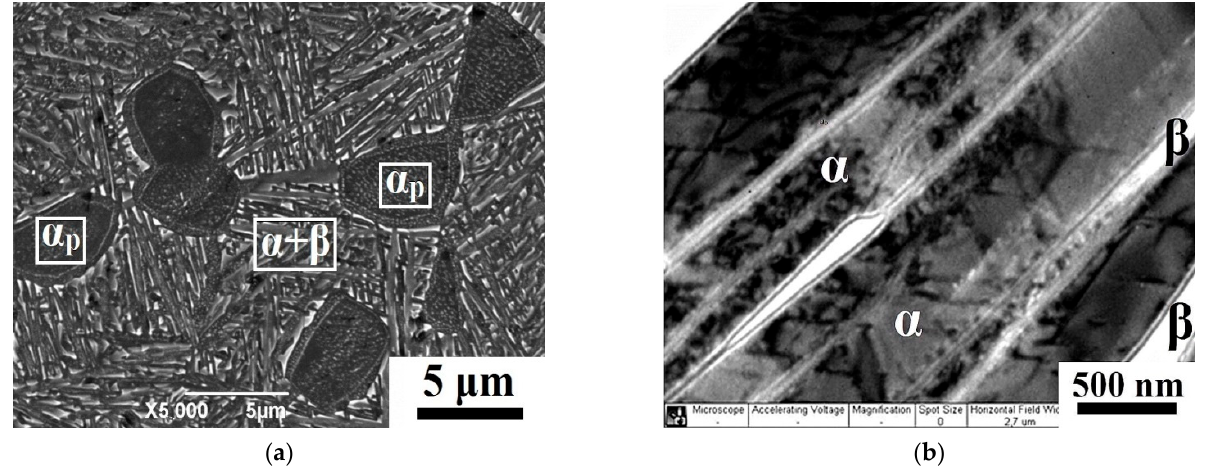
Figure 3. Microstructure of Ti ‐ 6Al ‐ 4V in the initial CG state: general view of structure, SEM ( a ); ( α + β ) area of lamellar structure, TEM ( b ).